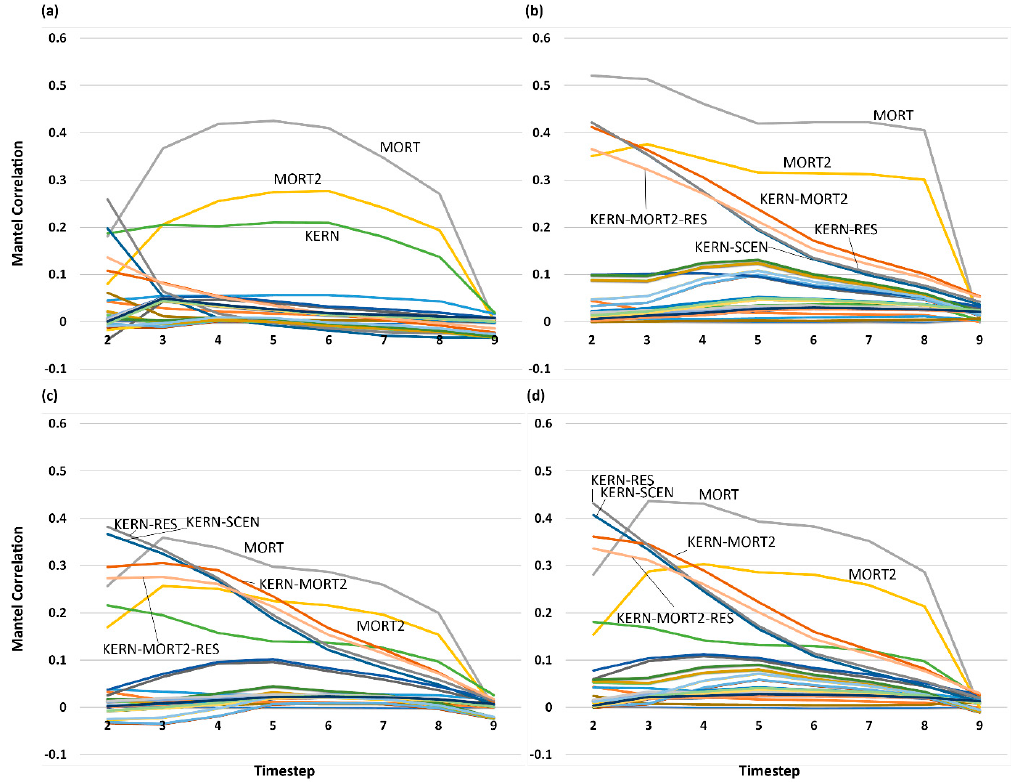
Figure 6. Mantel correlations between response variables ( a ) Kernel Extent, ( b ) Population Size, ( c ) Kernel Sum, and ( d ) multivariate distance between these response variables and divergence among scenarios over timesteps. Timestep is depicted on the x-axis with Mantel correlation on the y-axis. The highest correlating factors are labeled: MORT—mortality model matrix with all mortality scenarios coded 1 and non-mortality 0; MORT2—mortality model matrix with scenarios coded ordinally from highest to lowest degree of mortality risk; KERN—dispersal distance varying with kernel bandwidth; KERN-MORT2—model matrix combining KERN and MORT2 by addition; KERN-RES—model matrix combining KERN and resistance model matrices by addition; KERN-SCEN—model matrix combining KERN and highway mitigation model matrices by addition; and KERN-MORT2-RES—model matrix combining KERN, MORT2 and RES model matrices by